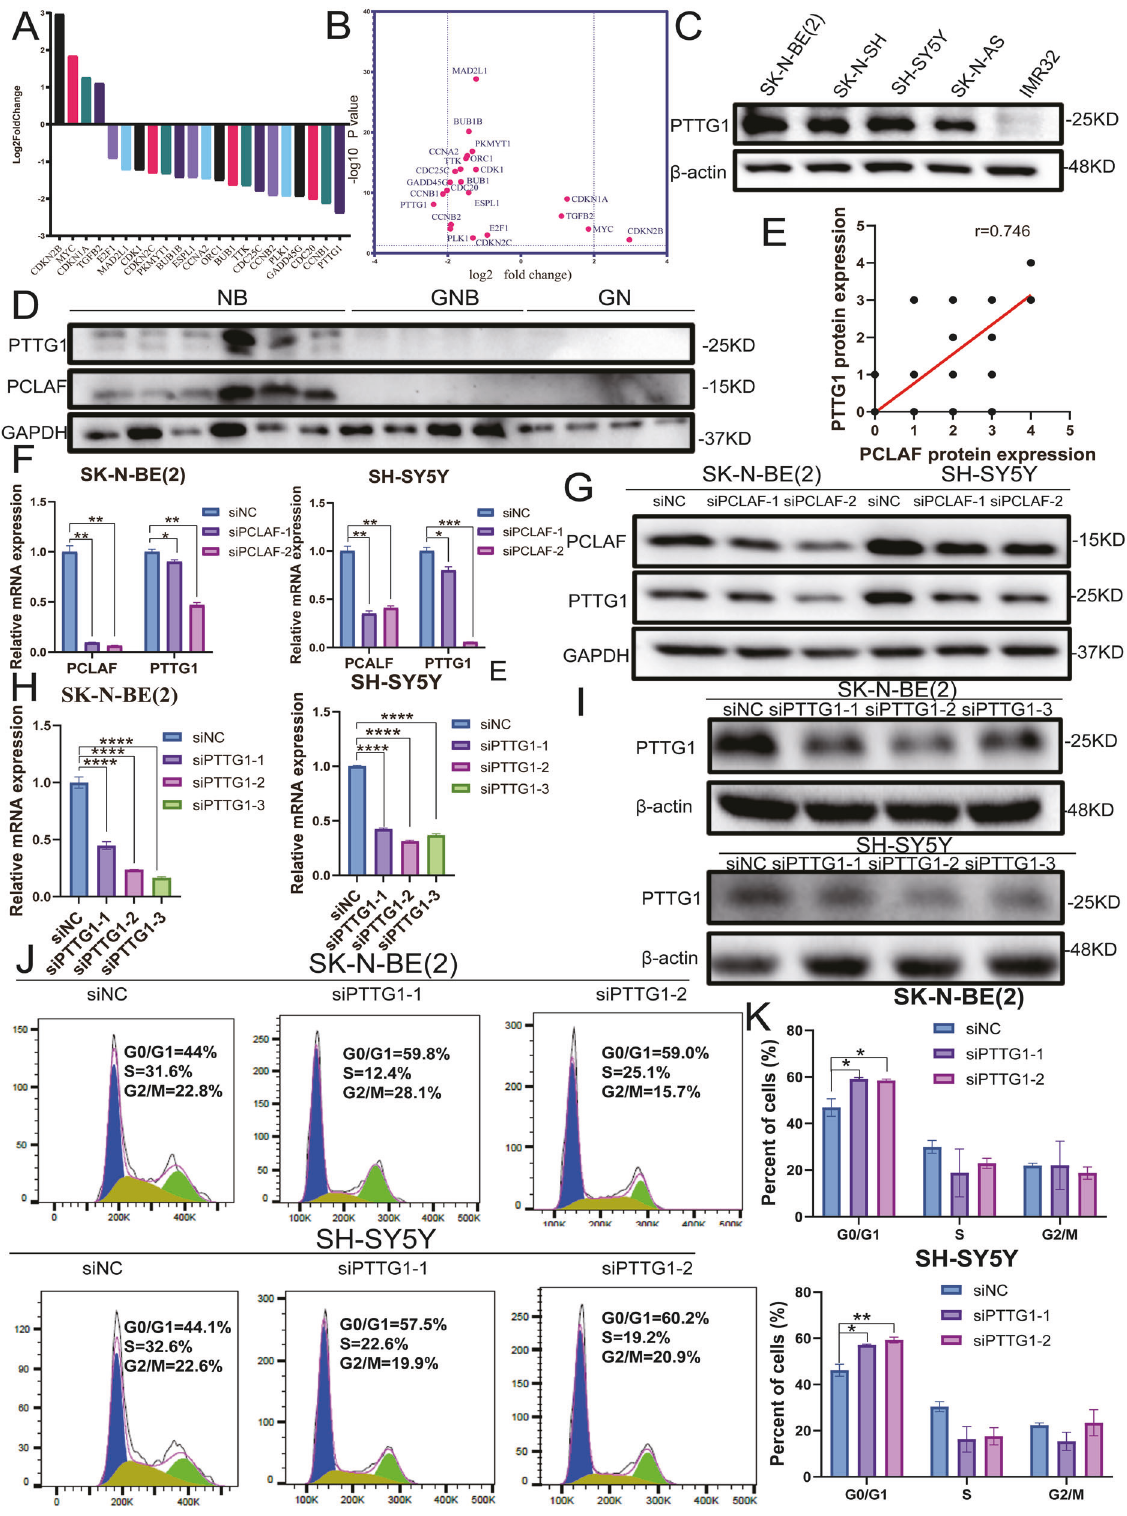
Fig. 4 PCLAF can regulate PTTG1 to promote G1/S cell cycle transition. ( A, B ) RNA-seq analyzed the mRNA level of the cell cycle signaling pathway after PCLAF knockdown; ( C ) Western blotting examined the protein expression of PCLAF in 5 neuroblastoma cell lines; ( D ) The expression of PTTG1 and PCLAF in clinical tissues was measured by western blot; ( E ) Spearman correlation analysis of the relationship between PCLAF and PTTG1 in identical clinical tissues ( r = 0.774, P < 0.01); ( F, G ) qRT-PCR and Western blot were used to detect the changes in PTTG1 mRNA and protein levels after interference PCLAF in SK-N-BE(2) and SH-SY5Y cell lines; ( H , I ) Interference ef fi ciency of 3 small interfering RNAs with different sequences on PTTG1 in SK-N-BE (2) and SH-SY5Y cell lines, detected by qRT-PCR and Western blotting; ( J, K ) Flow cytometry was used to analyze the cell cycle of neuroblastoma cell lines. (* p < 0.05, ** p < 0.01, *** p < 0.001and *** *p < 0.0001, and bar graphs represent the mean ± SEM). Cell Death and Disease (2022)